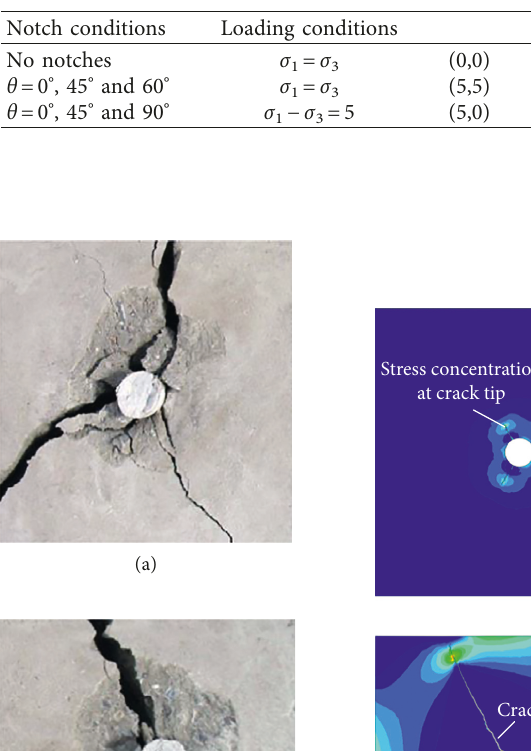
Table 2: The stress loading conditions (unit: MPa).